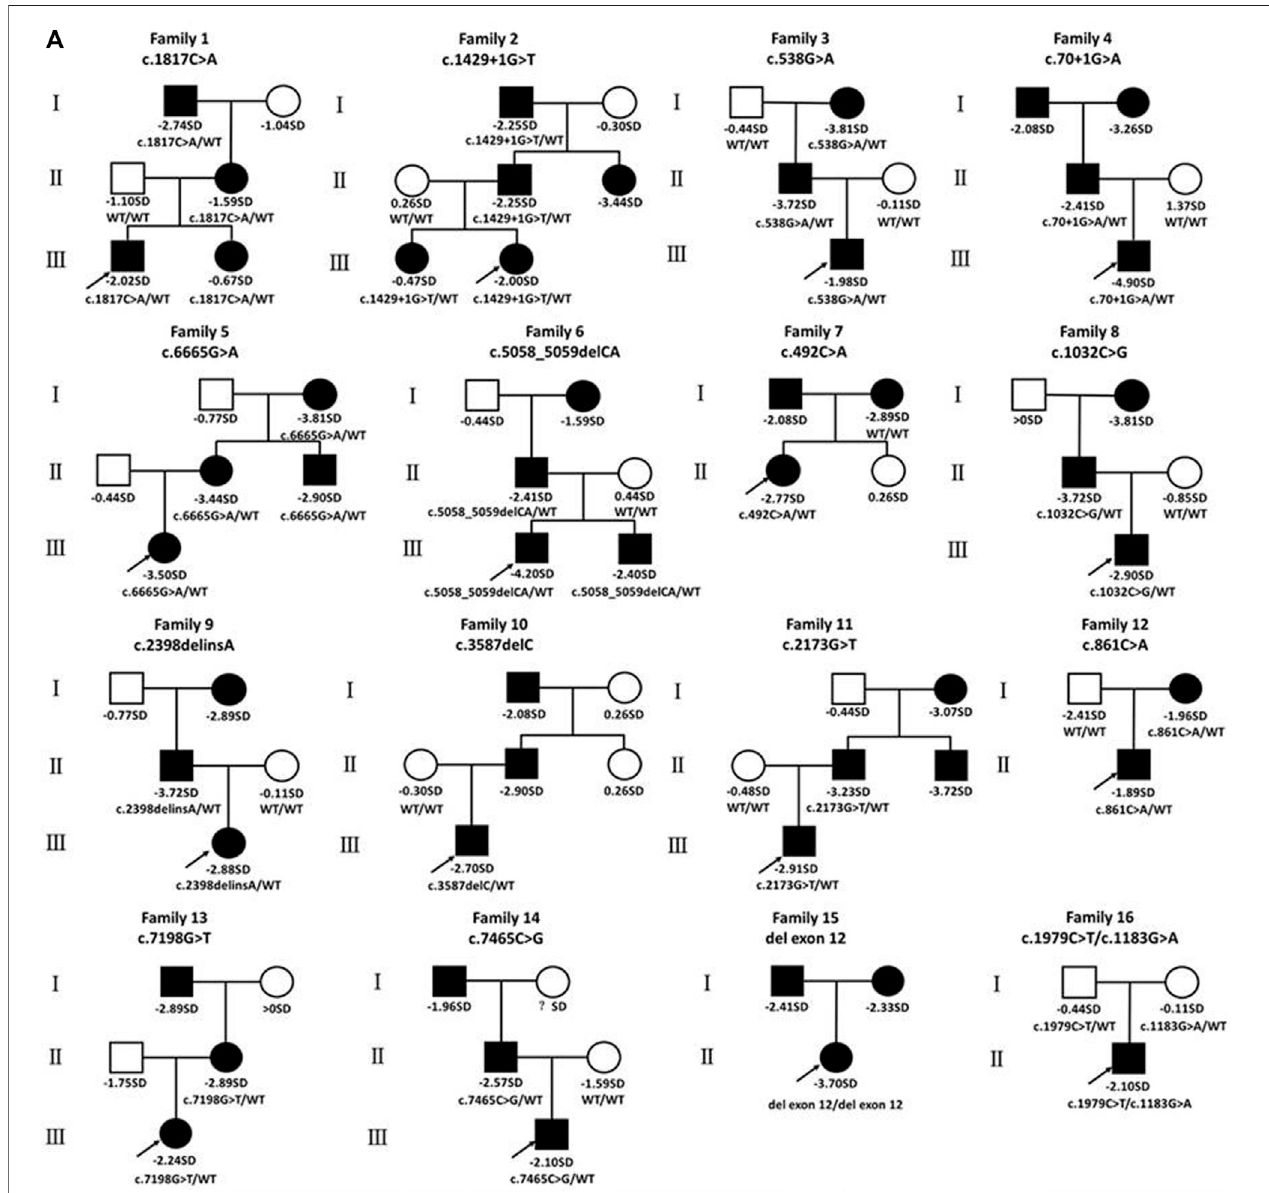
FIGURE 2 | Pedigrees of affected families and hand radiographs of the probands. (A) Pedigrees of 16 families with ACAN pathogenic variants. Squares indicate males, circles females, fi lled symbols indicate that the individual presented short stature, open symbols indicate healthy individuals. Probands are denoted by arrows. Abbreviation: ?, unknown phenotype. (B) Hand radiographs of individuals carrying ACAN variants